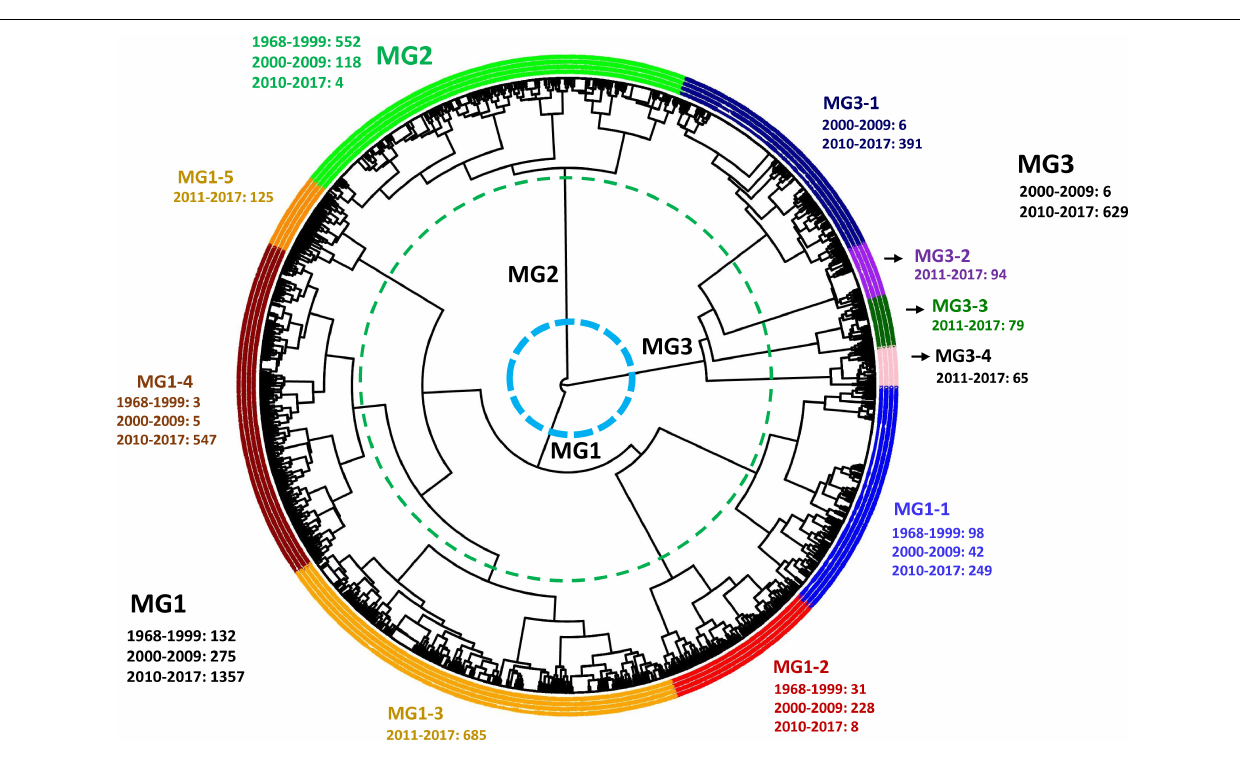
FIGURE 5 | Dendrogram of Puccinia striiformis f. sp. tritici populations from 1968 to 2009 and 2010 to 2017 in the United States constructed based on dissimilarities assessed with 12 simple sequence repeat markers (SSR) using the hierarchical cluster analysis, showing three major molecular groups (MGs) and 10 sub-MGs and the isolate numbers in 1968 to 2009 and 2010 to